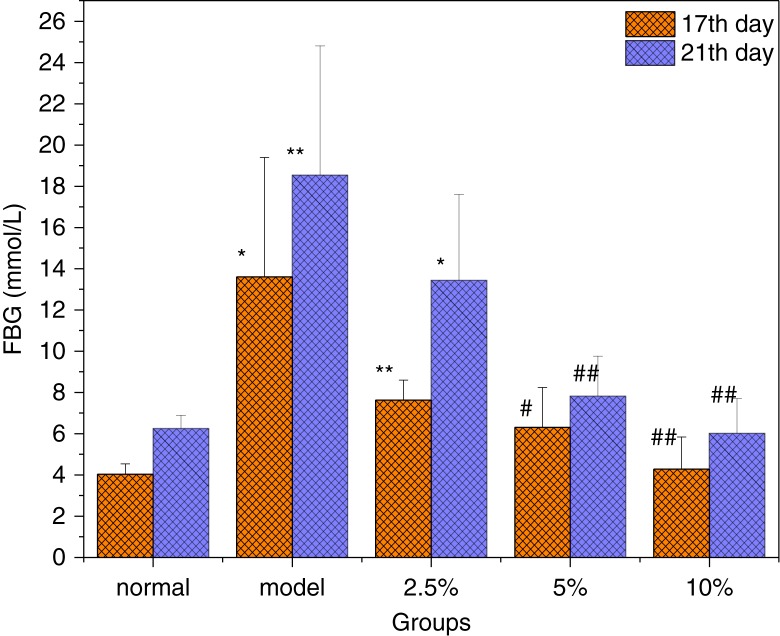
The effect of MBBP on FBG after STZ injection. Data are mean ±SE values (n=10). * and ** compared with the normal group with p<0.05 and p<0.01, respectively, significant differences. # and ## compared with the model group with p<0.05 and p<0.01, respectively, significant differences.